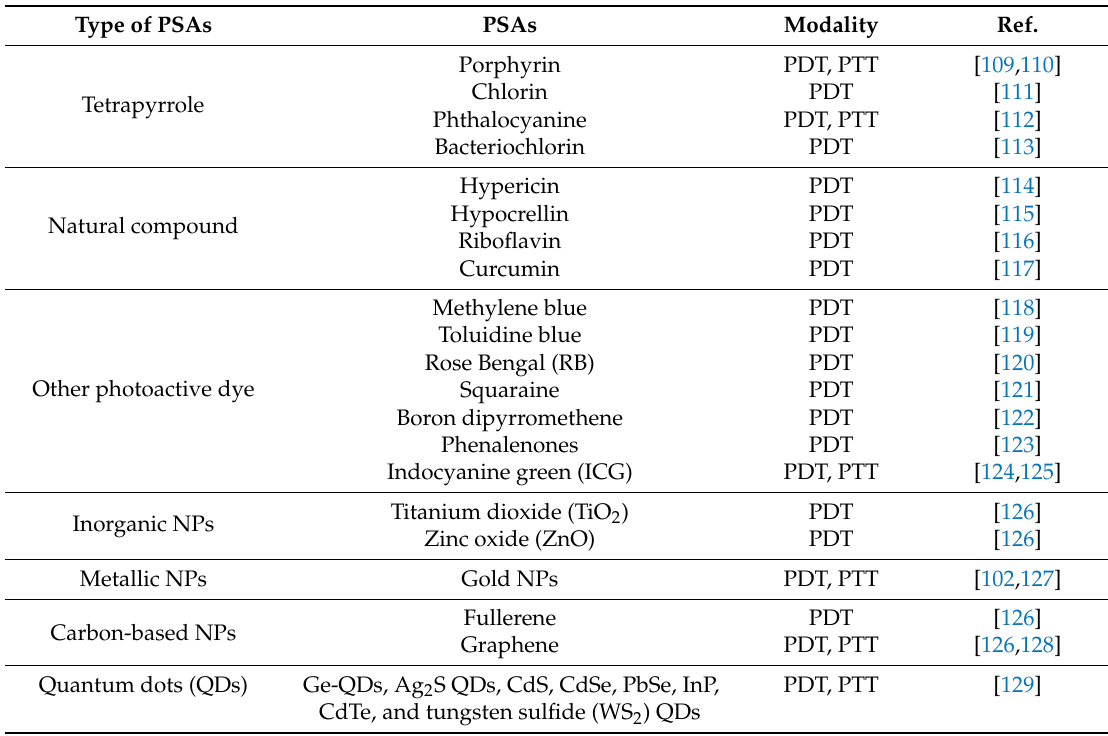
Table 3. Commonly investigated PT